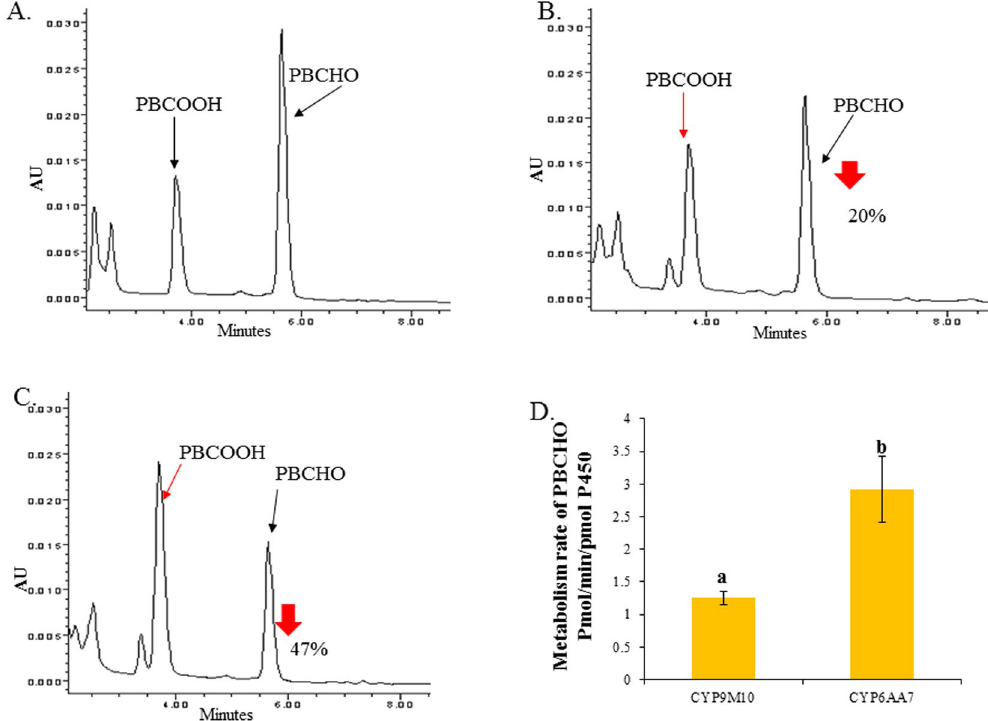
Figure 6. Metabolism profile of PBCHO by CYP6AA7/CPR and CYP9M10/CPR microsomes. ( A ) Control: PBCHO (10 µ M) treated with CYP/CPR microsomes (100 pmol P450 in 0.1 M Tris pH = 7.5) for 15 min at 30 °C without NADPH. The black arrows indicate the peaks for PBCHO and PBCOOH; ( B ) PBCHO metabolized by CYP9M10/CPR microsomes. The red arrows indicate the PBCOOH and the reduced amount of PBCHO; ( C ) PBCHO metabolized by CYP6AA7/CPR microsomes. The red arrows indicate the PBCOOH and the reduced amount of PBCHO; ( D ) Metabolism rate of PBCHO with different CYP/CPR microsomes. Statistical significance is represented by P ≤ 0.05, with the letters using one-way ANOVA.